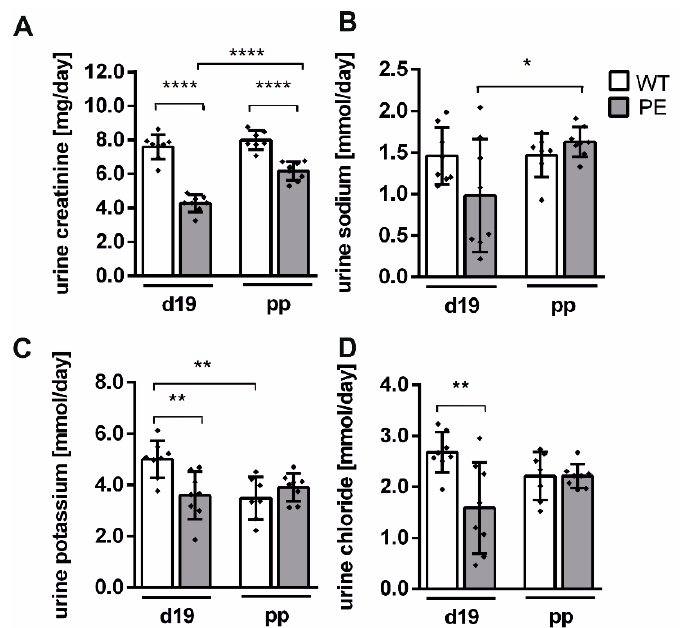
Figure 4. Urinary parameters were altered during PE and mostly restored after pregnancy. Amounts of urine creatinine ( A ), sodium ( B ), potassium ( C ), and chloride ( D ) are displayed per day. All parameters were reduced on day 19 of preeclamptic pregnancy (PE) compared to respective controls (WT). Urine creatinine was less reduced in PE on day 49. Sodium, potassium, and chloride recovered after PE pregnancy. Statistical analysis was done with a two-way ANOVA. Mean ± SD is indicated ( n = 7–8). p -value is shown * p ≤ 0.05; ** p ≤ 0.01; **** p ≤ 0.0001.